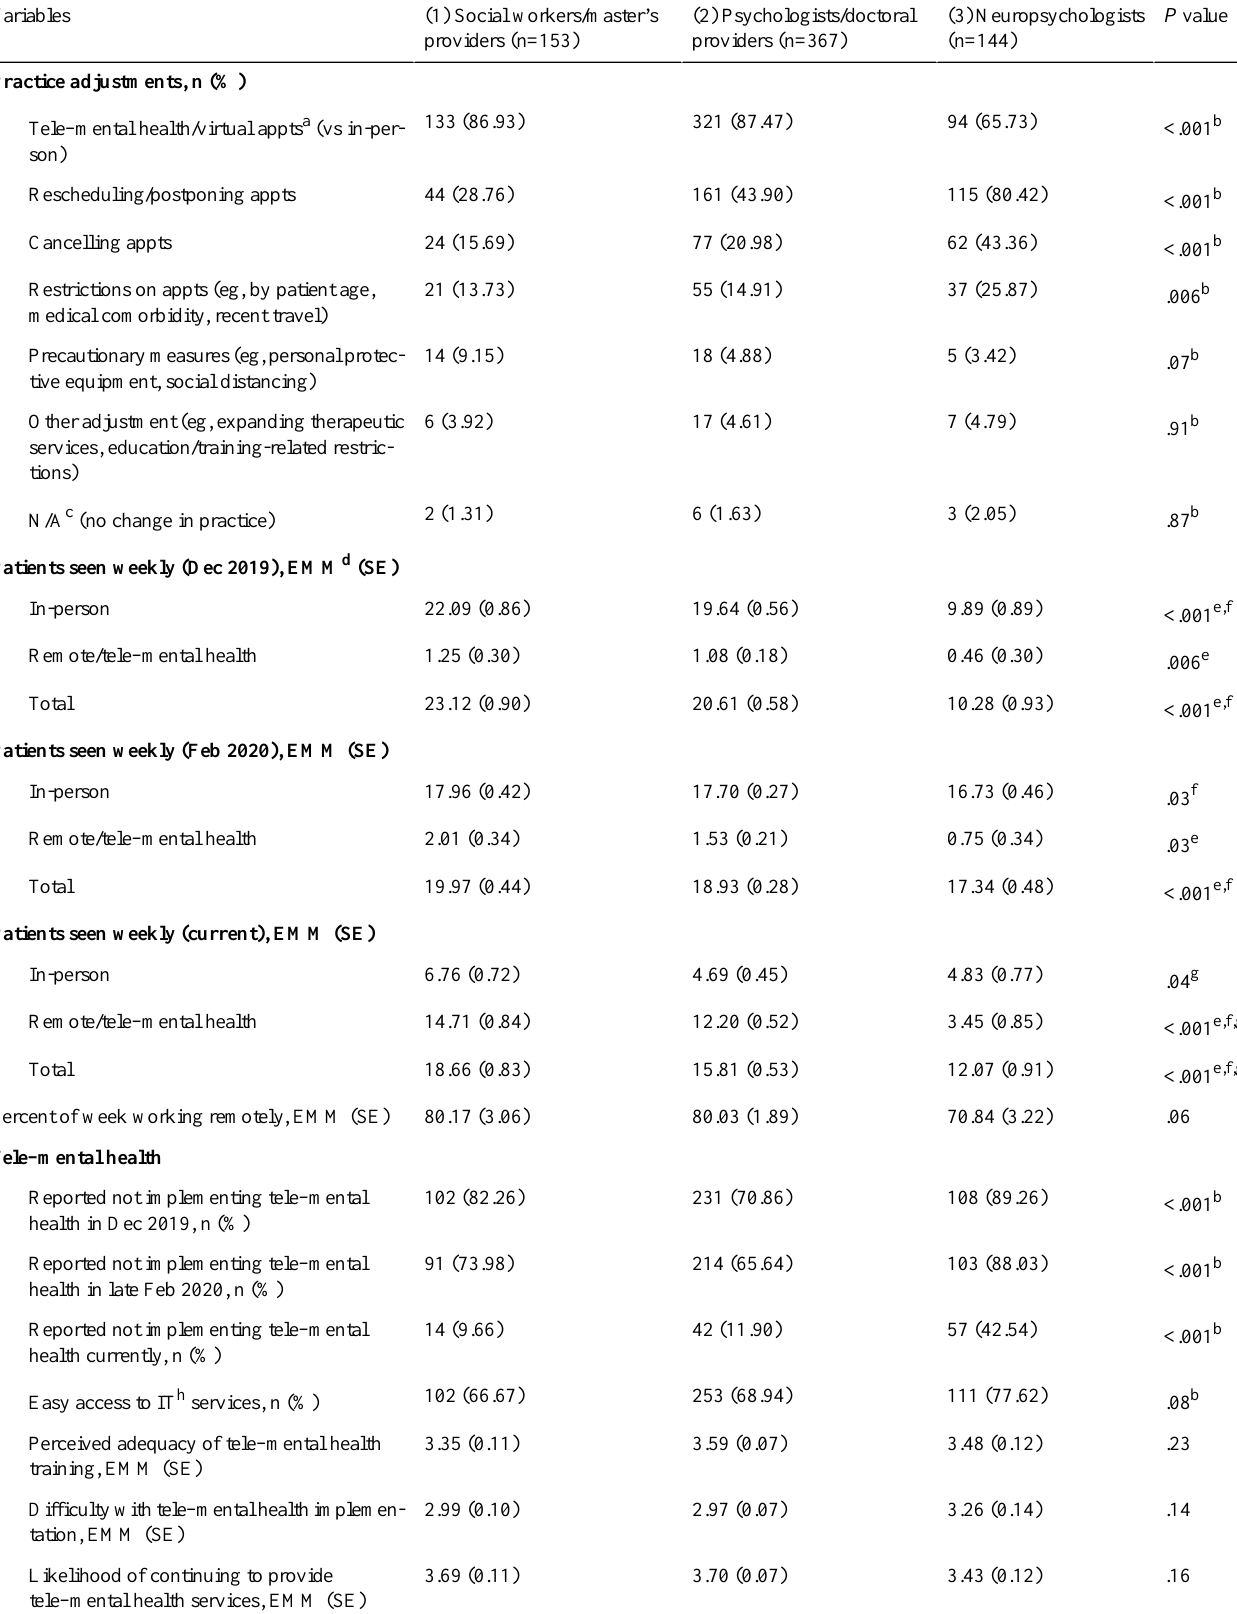
Table 5. Results of chi-squares for practice adjustments and analyses of covariance for patients seen and tele–mental health factors during COVID-19 by provider